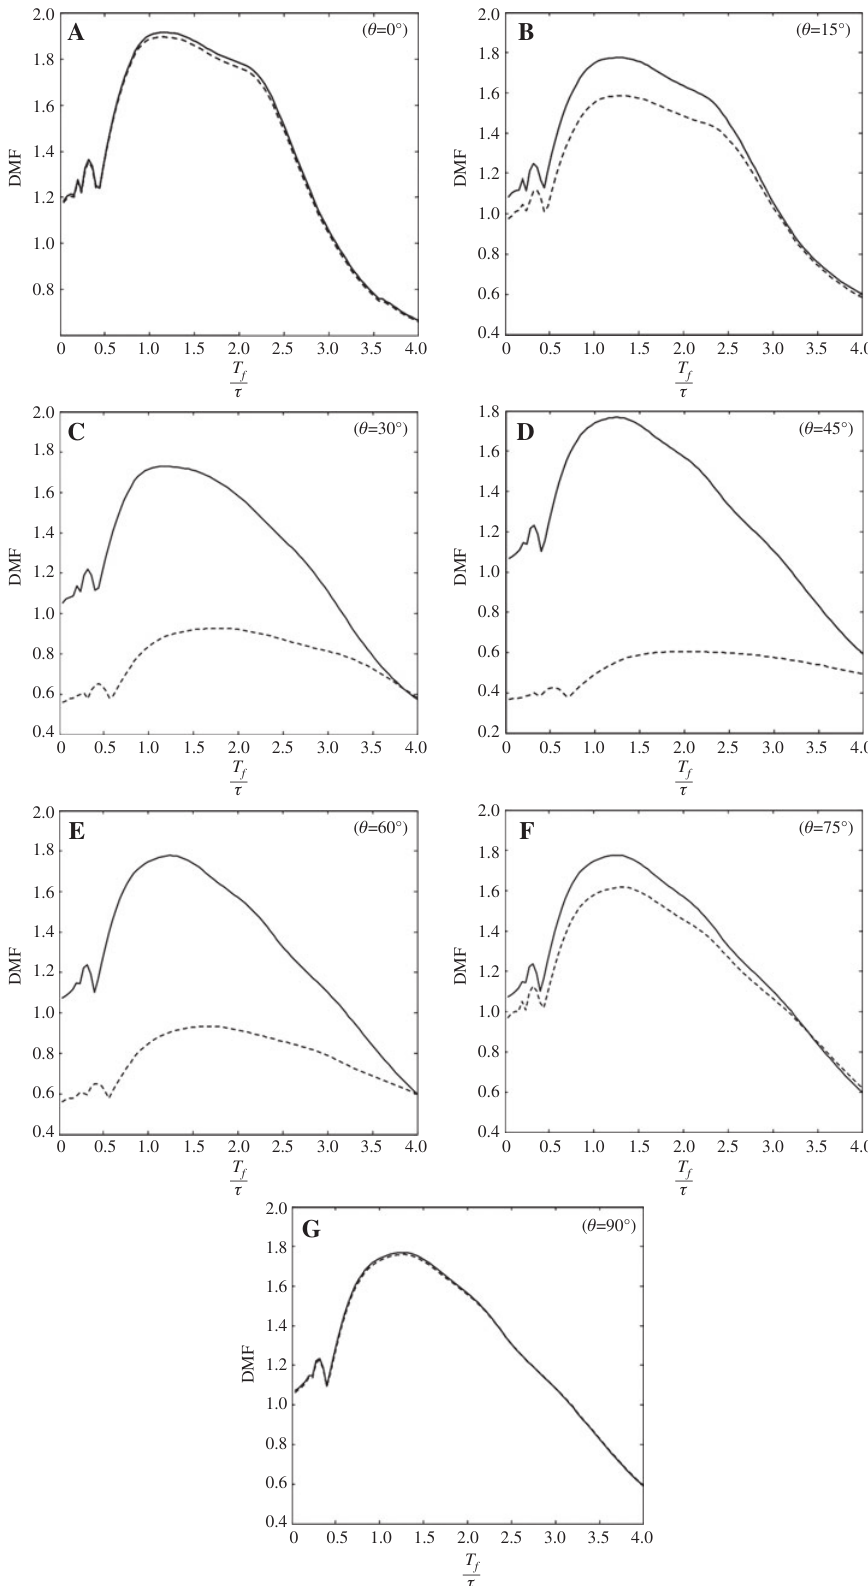
Figure 9 Infl uence of the Poisson ’ s effect on the DMF vs. T – – – – without considering the Poisson ’ s effect